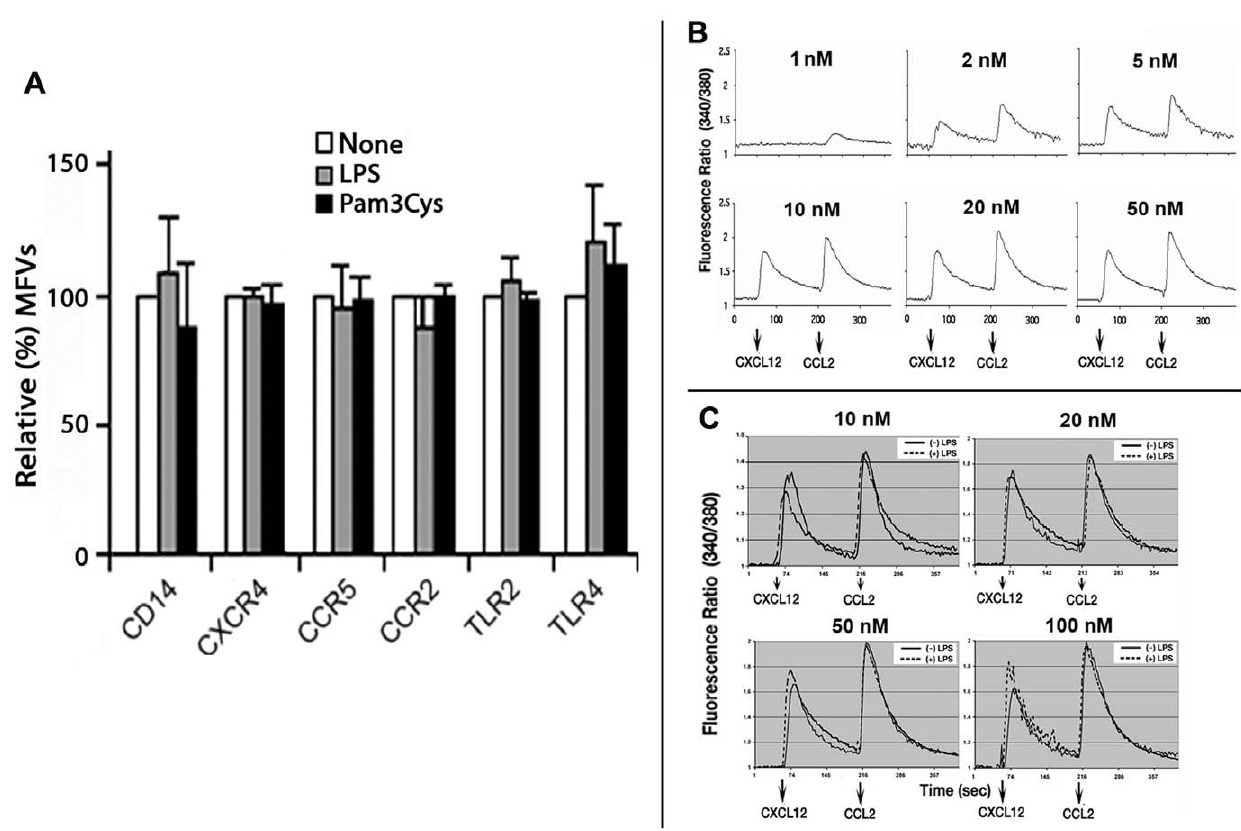
Figure 3. Short term stimulation of monocytes with TLR2 or TLR4 ligand did not significantly modulate cell surface expression of selected immune cell receptors and LPS treatment did not alter the G-protein signaling potential (as measured by intracellular Ca 2 + flux) to CXCL12 or CCL2 treatment(s). A ) Monocytes were treated with LPS (2 ng/ml) or Pam 3 CSK 4 (50 ng/ml) for 15 min before staining with fluorescent mAbs against the indicated immune cell receptors. Receptor densities were measured by flow cytometry and the MFVs in stimulated cells are expressed relative (%) to untreated cells as histograms (with error bars, n=3). B ) Agonist dose response of intracellular Ca 2 + flux to sequential stimulation with CXCL12 and CCL2 in monocytes. C ) Ca 2 + flux profiles of LPS (2 ng/ml, for 15 min after calcium dye loading) treated (interrupted line) and untreated monocytes to sequential stimulation with increasing concentrations of CXCL12 and CCL2. Plots represent results using monocytes from four